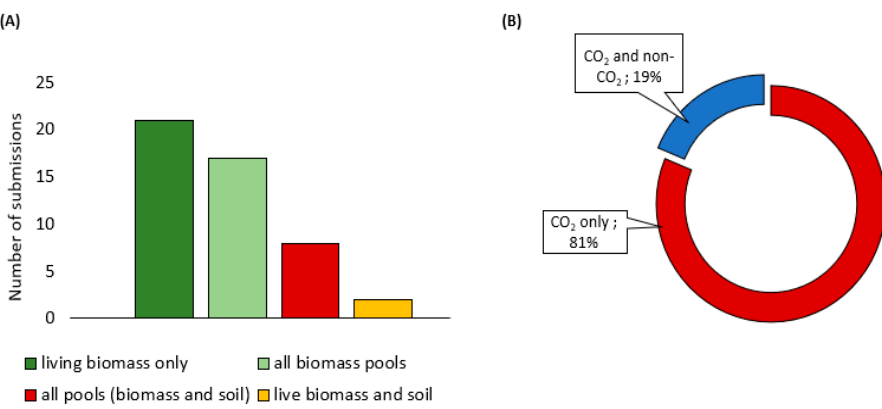
Figure 3. ( A ) Number of FREL submissions to the UNFCCC that include only living biomass carbon pools, all biomass (i.e., living and dead) carbon pools, all carbon pools (i.e., all biomass and soil), or only living biomass and soil carbon pools. ( B ) Proportion (%) of FREL submissions to the UNFCCC that include only CO 2 gases (red) and CO 2 and non-CO 2 gases (blue).